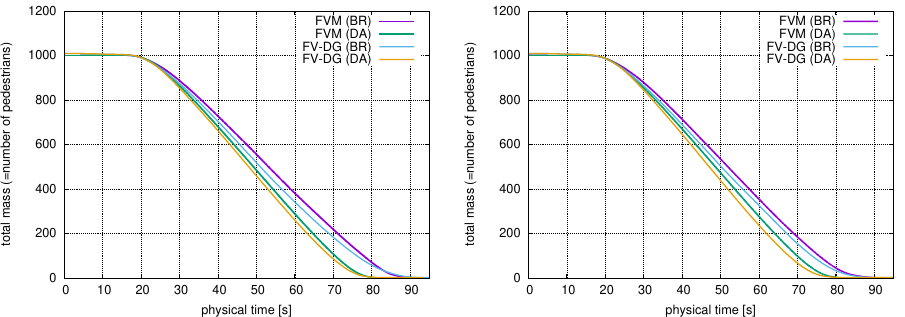
Figure 8. H-shape domain, the time evolution of the total number of pedestrians M ( t m ) for the finest grid ( left ) and for the coarsened grid ( right